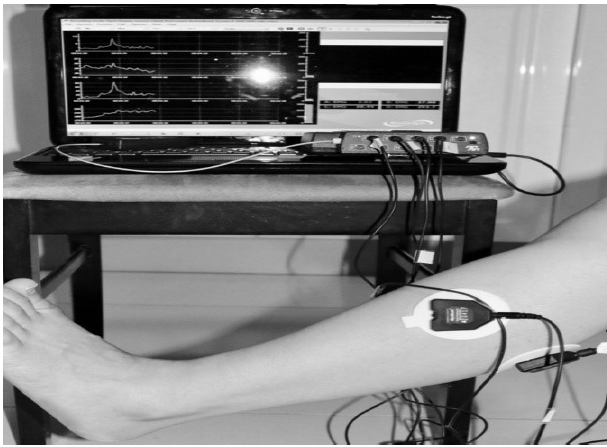
Figure 3. Knee Flexion with Flexion Dorsiflexion.